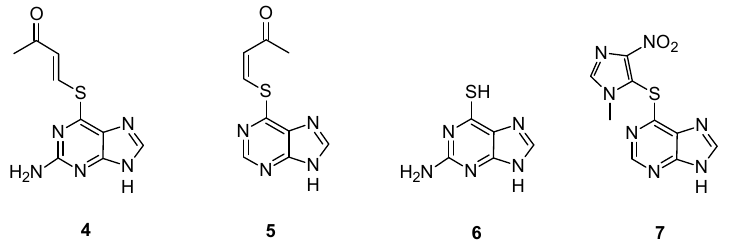
Figure 3. Chemical structure of compounds 4 , 5 , 6 and 7